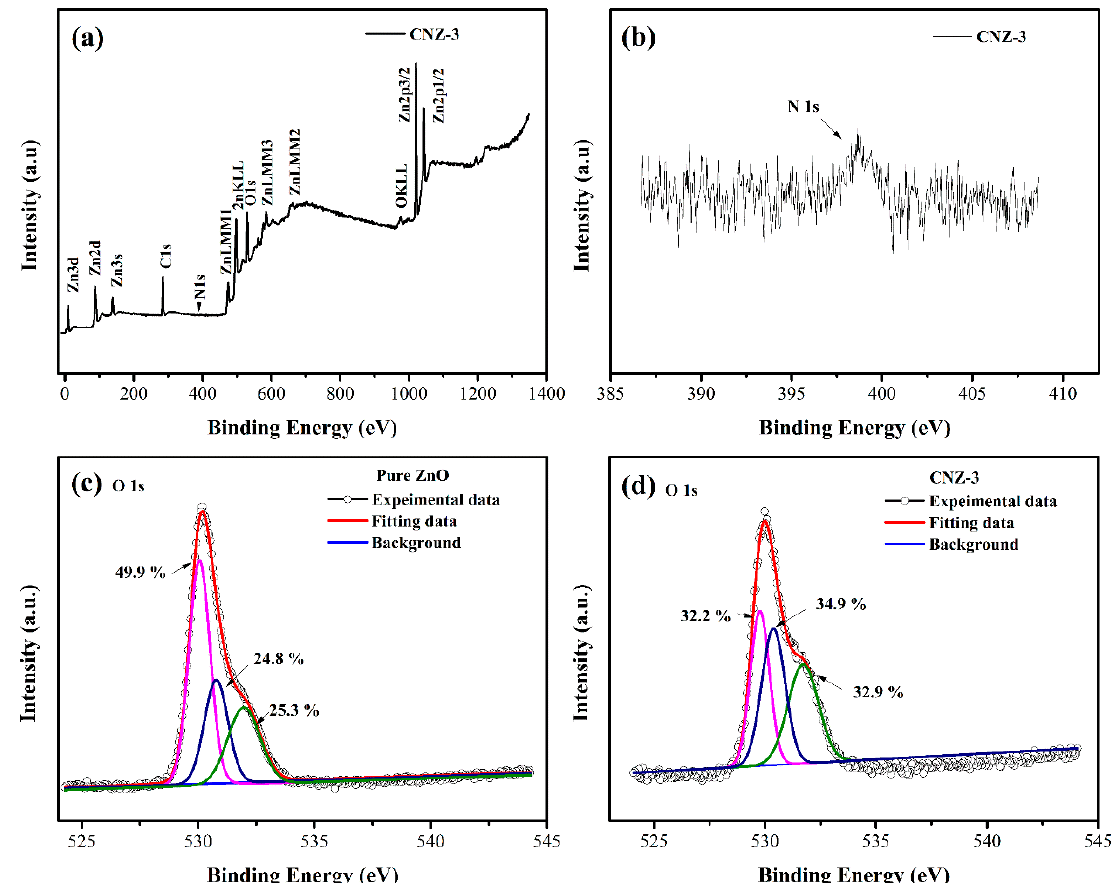
Figure 7. XPS spectra of the prepared sample: ( a ) full survey scan spectrum of CNZ-3, ( b ) high resolution of N 1s spectrum of CNZ-3, and O1s spectra of ( c ) pure ZnO and ( d ) CNZ-3.